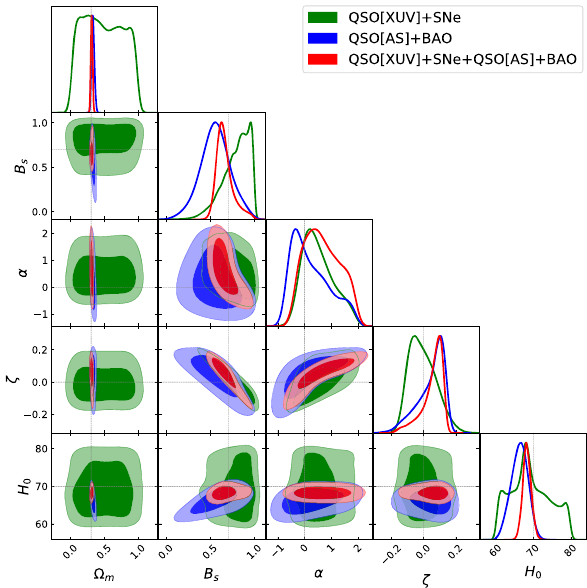
Fig. 5 The 1D and 2D probability distributions of model parameters in the VGCG